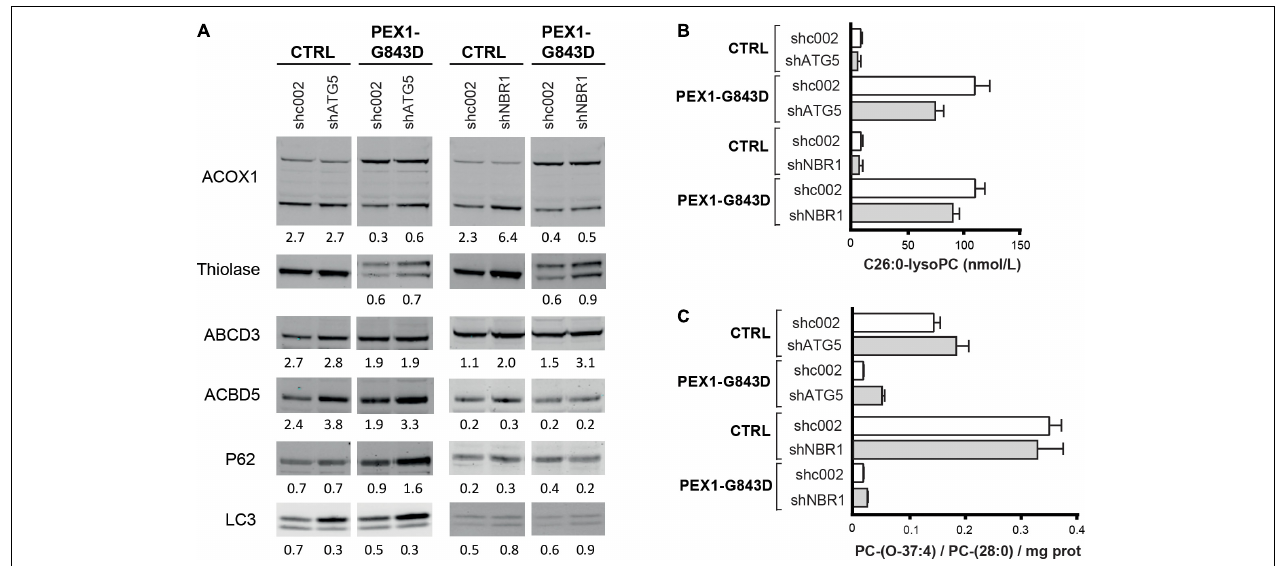
FIGURE 7 | Effect of depletion of ATG5 or NBR1 in primary PEX1-G843D fibroblasts on peroxisomal matrix protein import and peroxisomal metabolic functions. (A) Immunoblot analysis of homogenates of primary PEX1-G843D fibroblasts and control fibroblasts that stably express shRNAs against ATG5 (shATG5) or NBR1 (shNBR1) or, as control, a non-specific scrambled shRNA (shc002). Cells were treated with the different compounds as described in Figure 1A . The relative protein levels of ACBD3, ABCD5 and P62 (corrected for tubulin or actin levels), the ratios of LC3-II over LC3-I and the ratios of the processed over unprocessed forms of PTS1-targeted ACOX1 and PTS2- targeted thiolase were determined as described in the legends of Figure 2 . (B) C26:0-lysophosphatidylcholine (C26:0-lysoPC) levels measured in primary PEX1-G843D fibroblasts and control fibroblasts that stably express shRNAs against ATG5 (shATG5) or NBR1 (shNBR1) or a non-specific scrambled shRNA (shc002). (C) De novo synthesis of the ether phospholipid PC-(O-37:4) in primary PEX1-G843D fibroblasts and control fibroblasts that stably express shRNAs against ATG5 (shATG5) or NBR1 (shNBR1) or a non-specific scrambled shRNA (shc002) (expressed as PC-(O-37:4) over PC-(28:0) over mg protein; PC-(28:0) used as internal standard). Experiments were repeated twice; shown are representative blots from one experiment (A) and the means (B,C) .